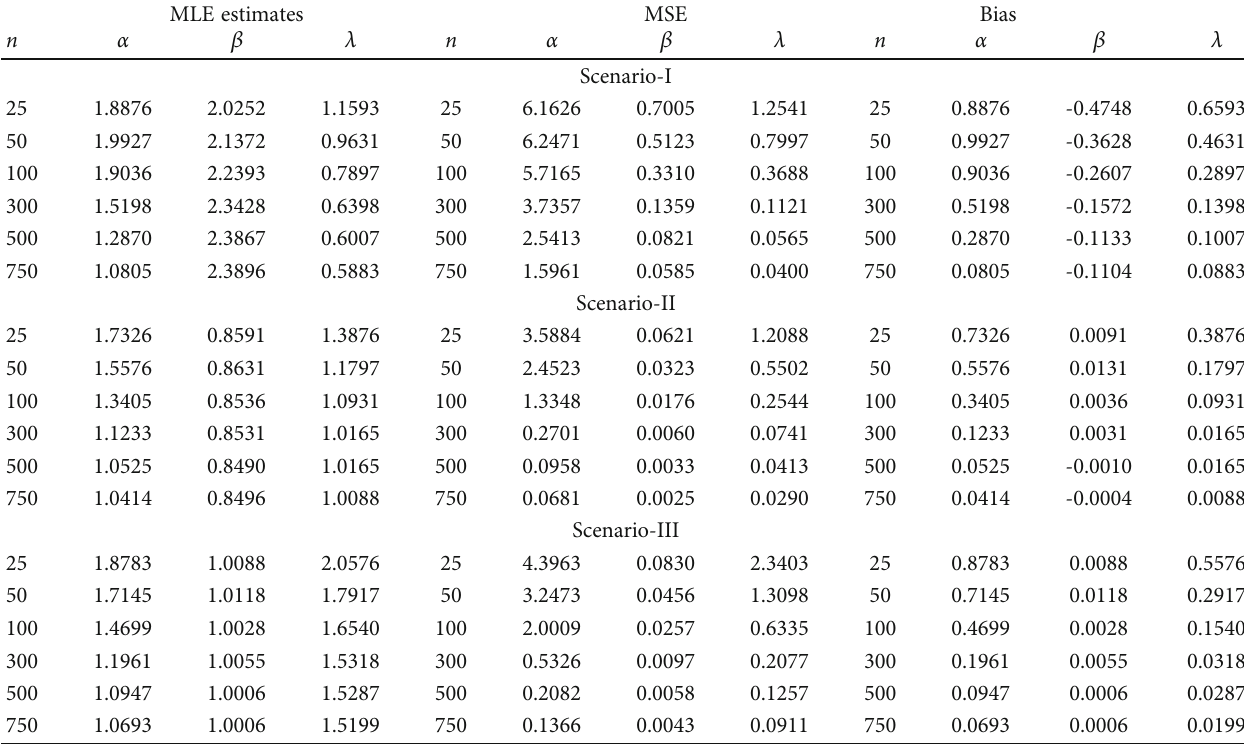
Table 1: Detailed summary of simulation analysis of